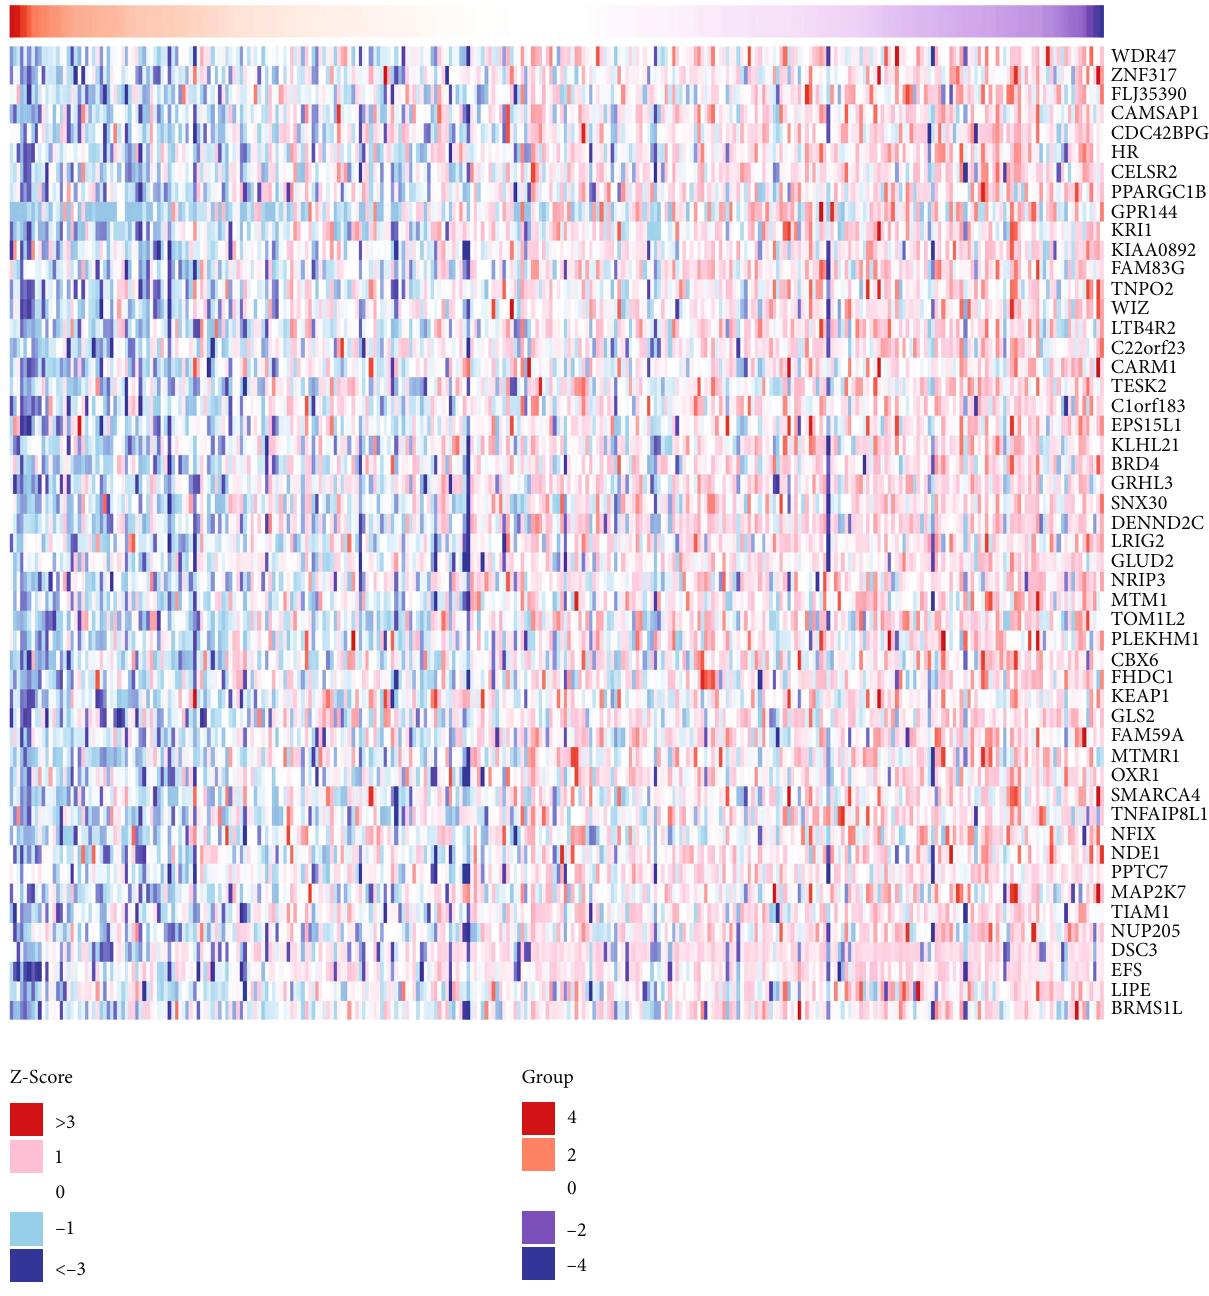
Figure 9: (a) PDIA3 di ff erentially co-expressed top 50 positive related genes in cervical cancer. (b) PDIA3 di ff erentially co-expressed top 50 negative related genes in cervical